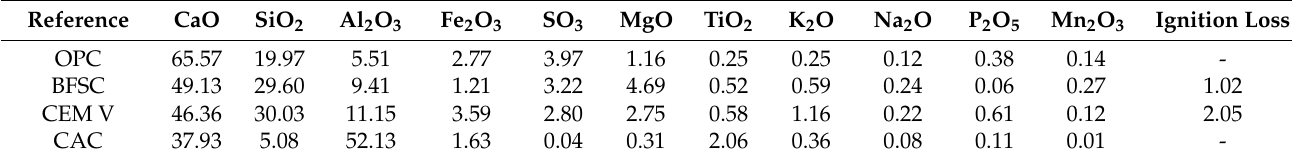
Table 1. Chemical composition (in wt.%) of the different cements used in this study.